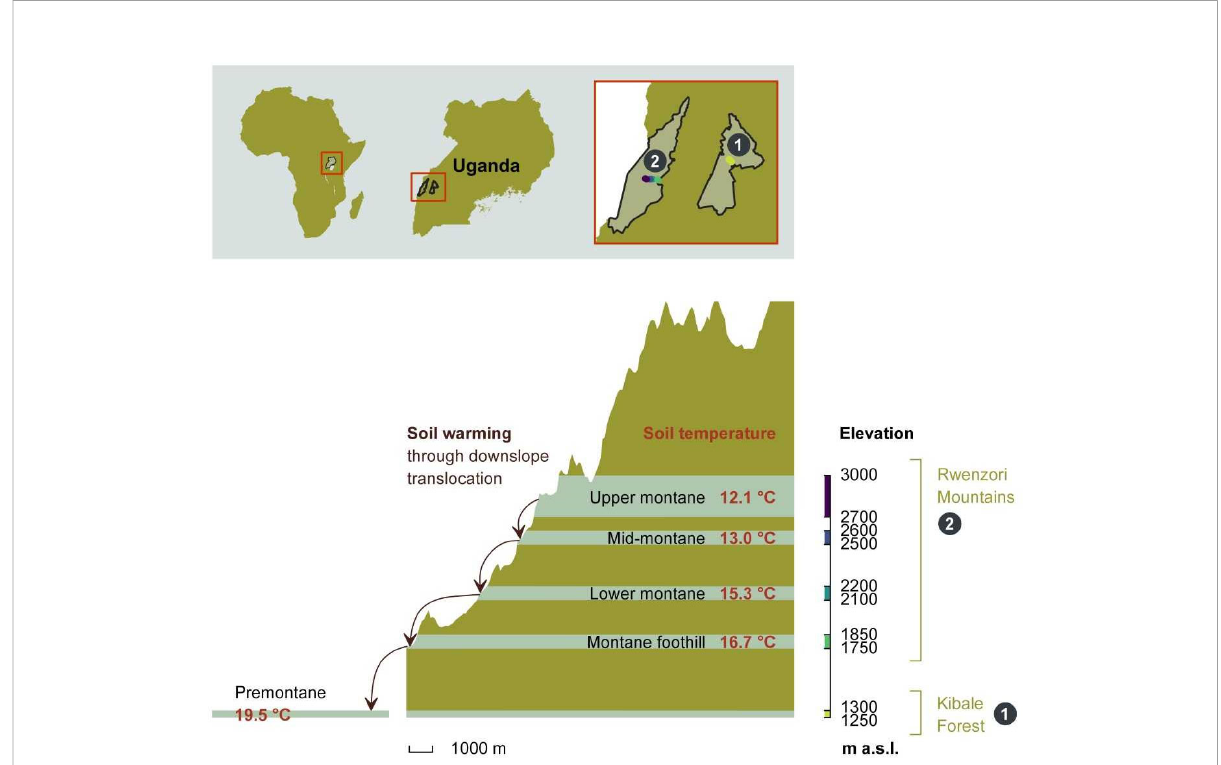
FIGURE 1 The height pro fi le of the Rwenzori elevational gradient starting from nearby premontane Kibale Forest National Park (1,250 – 1,300 m a.s.l.) onto the Rwenzori Mountains National Park (1,750 – 3,000 m a.s.l.). Mean annual in situ temperatures for each of the fi ve elevation clusters are indicated. The setup of in situ warming through downslope translocation of soil cores to the immediate lower elevation cluster is illustrated on the left side of the scheme. Different colors on the elevation axis represent the color code for each elevation cluster throughout the